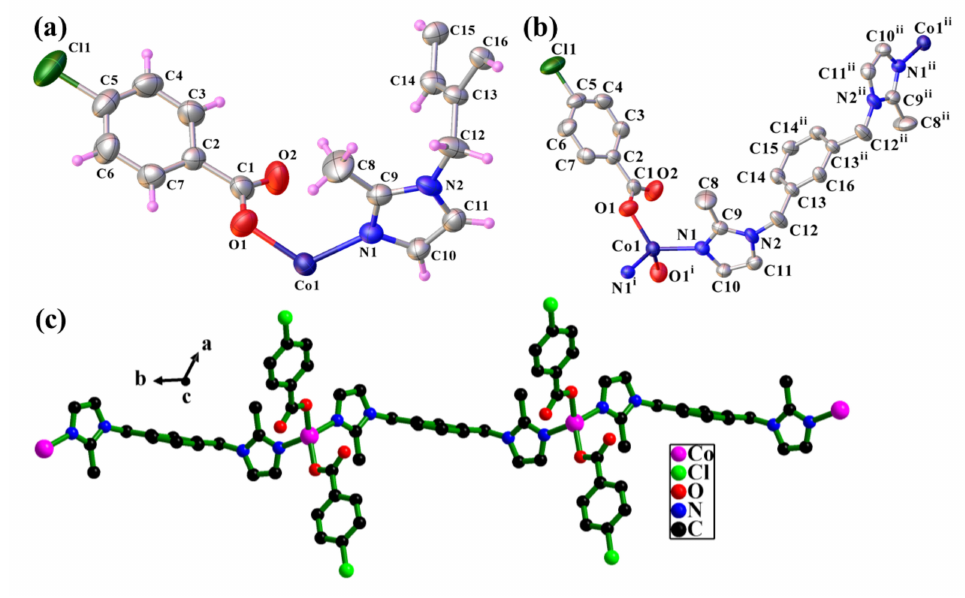
Figure 1. ( a ) The asymmetric unit of 1 . ( b ) The coordination environment for Co 2+ in 1 . ( c ) The 1D chain framework in 1